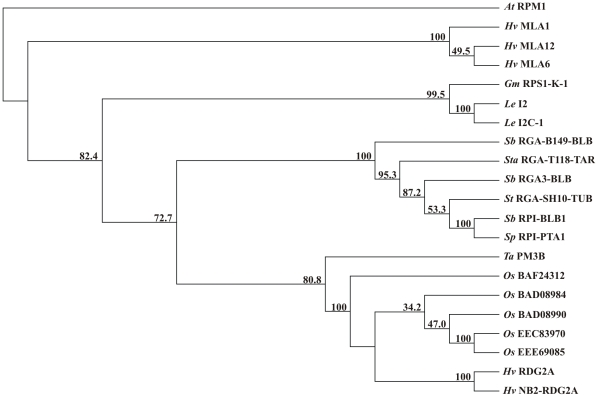
Neighbor-joining phylogenetic tree including RDG2A and similar resistance proteins and resistance gene analog products.Numbers on the branches indicate bootstrap percentages. Prefixes indicate species origin. The A. thaliana RPM1 protein (Q39214) was used as an outgroup. Shown are the rice (Oryza sativa) disease resistance-like proteins BAF24312, BAD08984, BAD08990, EEC83970 and EEE69085, the PM3 wheat powdery mildew resistance protein, products of the S. bulbocastaneum blight resistance gene Rpi-blb1 and its paralogues Rga3-blb, and Rpi-blb1, predicted products of RGA_B149.blb, RGA_T118-tar (S. tarijense), RGA_SH10-tub (S. tuberosum) and Rpi-pta1 (S. papita), the I2 and I2C-1 proteins encoded by the tomato (Lycopersicon esculentum) I2 resistance locus to Fusarium wilt, the soybean (Glycine max) Phytophthora root rot resistance protein RPS-L-K-1, and the barley (H. vulgare) powdery mildew resistance proteins MLA1, MLA6 and MLA12.